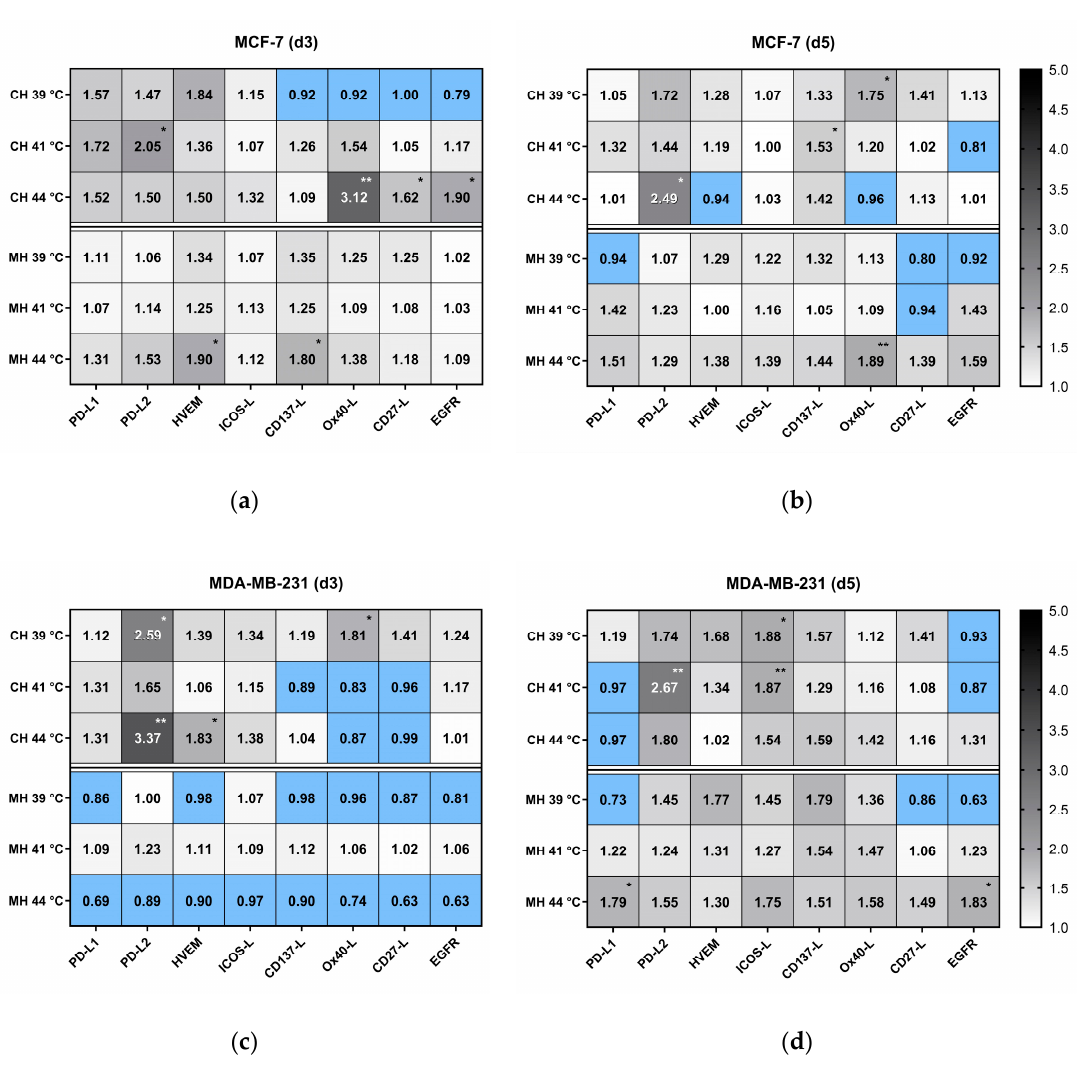
Figure 9. Heatmap of normalized expression (change in mean fluorescence intensity compared to mock-treated cells) of immune checkpoint molecules and of EGFR on the cell surface of ( a , b ) MCF-7 and ( c , d ) MDA-MB-231 breast cancer cells after conventional warm-water (CH) or microwave heating (MH) on day 3 (d3) (a and c) and day 5 (d5; b and d). Cells were heated either by CH or MH within the self-designed hyperthermia system to three clinically relevant temperatures, i.e., 39 °C, 41 °C and 44 °C, for an effective time of 60 min. Afterwards, the cells were distributed into 75 cm 2 T-flasks for analysis on d3) and d5. Significance test was conducted using Kruskal-Wallis test with uncorrected Dunn´s multiple comparison from three independent experiments, each measured in duplicates. * ( p < 0.1), ** ( p < 0.01).